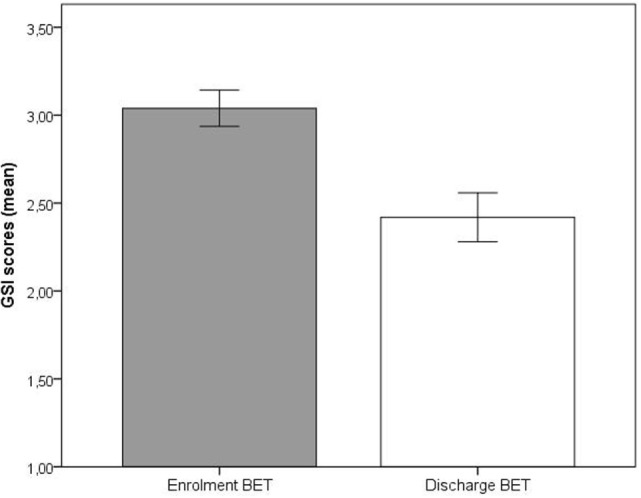
Changes in Global Severity Index from enrollment to discharge. Lines are SEs.